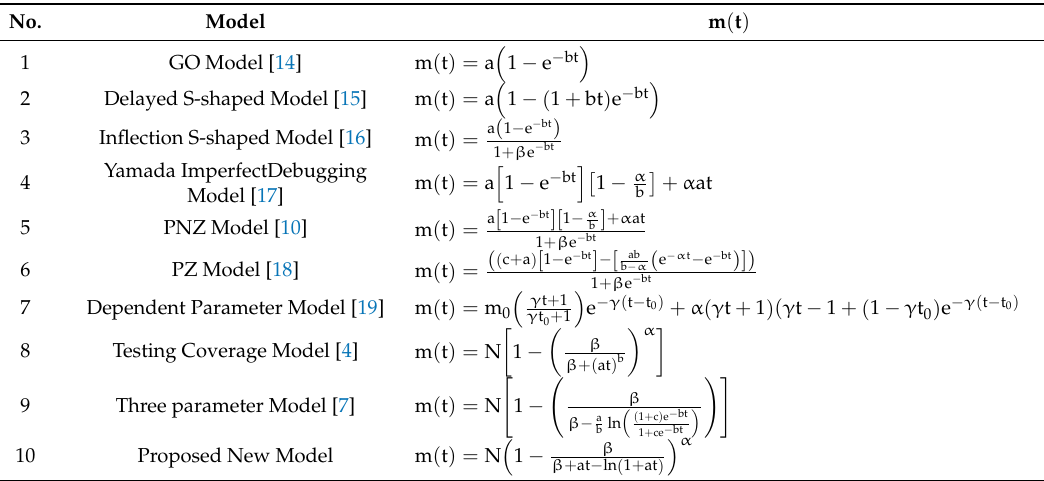
Table 1. NHPP software reliability models.